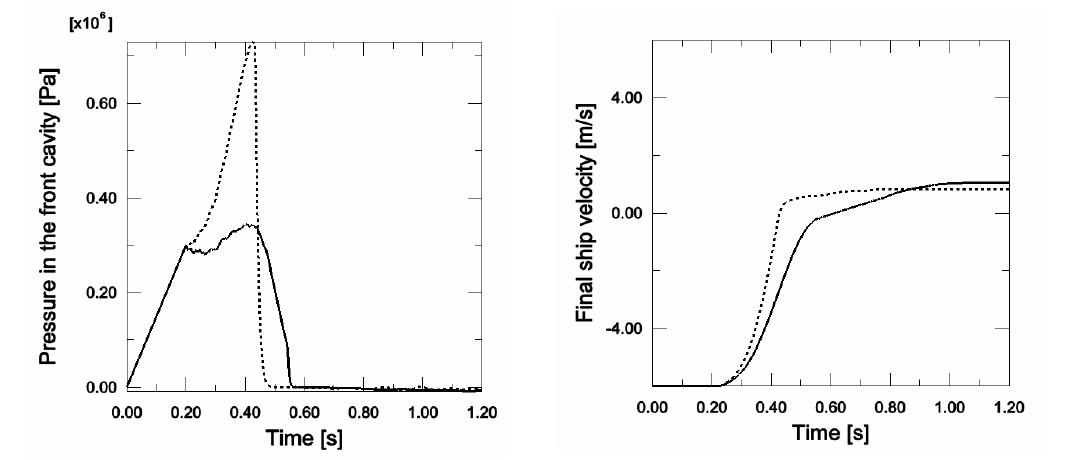
Fig. 10. Active mitigation of ship rebound: a) pressure of the gas in the cavity, b)corresponding final velocity of the